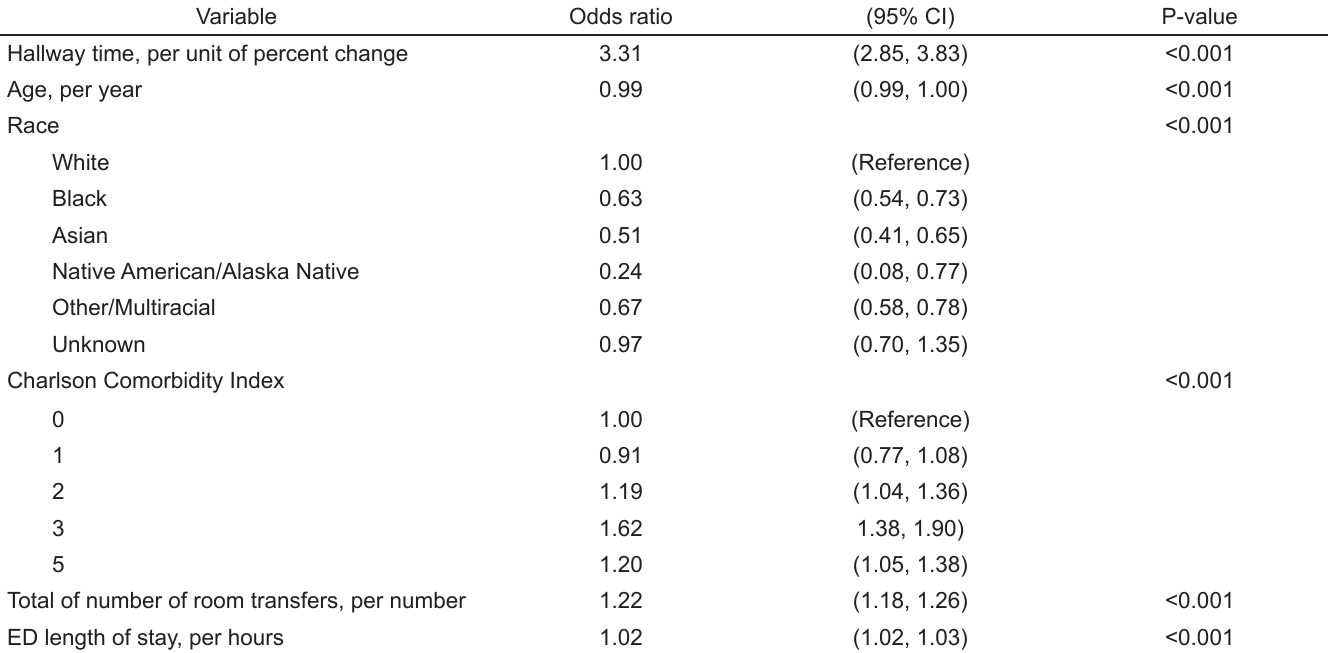
Table 5. Multivariable logistic regression model of the independent association between percent hallway time and development of delirium (n =